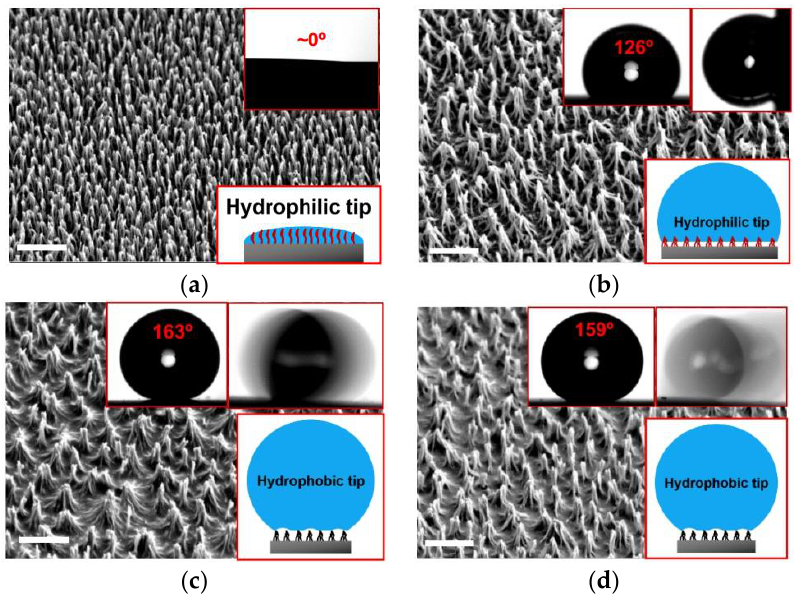
Figure 2. SEM images of the polymer nanostructures obtained with the oxygen plasma etching for 420 s, followed by different types of hydrophobic coatings. ( a ) Initial polymer nanostructures after the plasma etching (i.e., no hydrophobic coating). ( b ) Spin coating with PTFE. ( c ) SAM coating of FDTS in a dipping mode. ( d ) Spin coating with PTFE, followed by the SAM coating of FDTS in a dipping mode. The scale bar in each SEM image represents 1 µm. Insets in each image show the measurements of CA and CAH/SA, as well as the schematics of the wetting states.